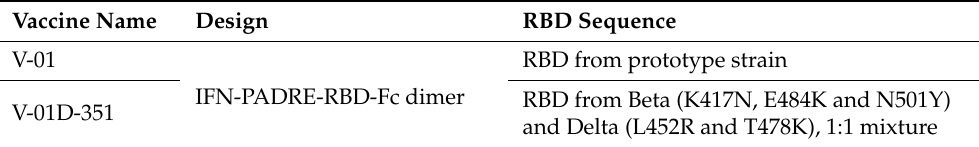
Table 1. Information of the investigational vaccine. Vaccine Name Design RBD Sequence V-01 RBD from prototype strain IFN-PADRE-RBD-Fc dimer RBD from Beta (K417N, E484K and N501Y) V-01D-351 and Delta (L452R and T478K), 1:1 mixture RBD, receptor-binding